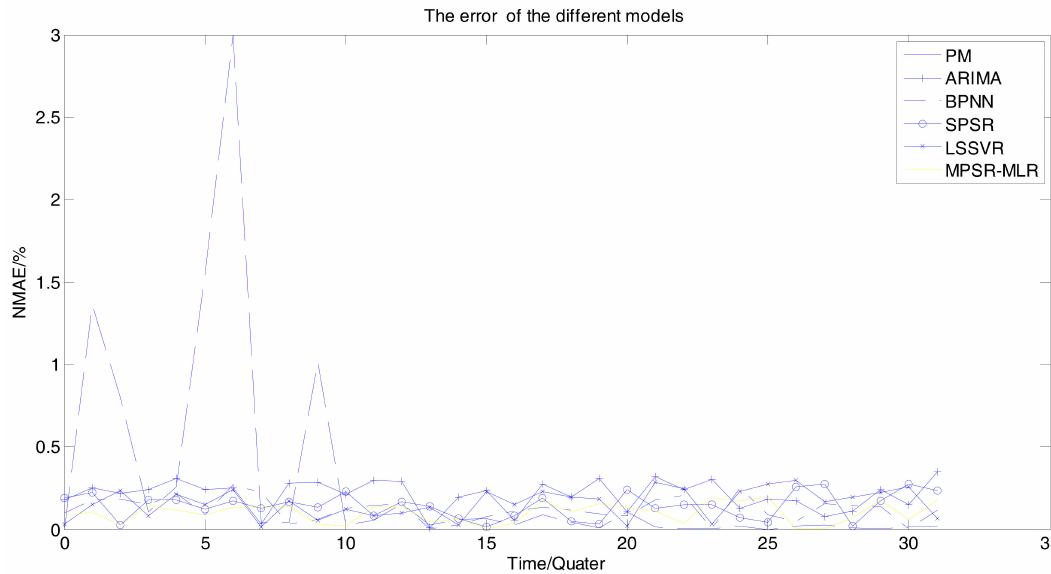
Figure 8. The errors of different wind power